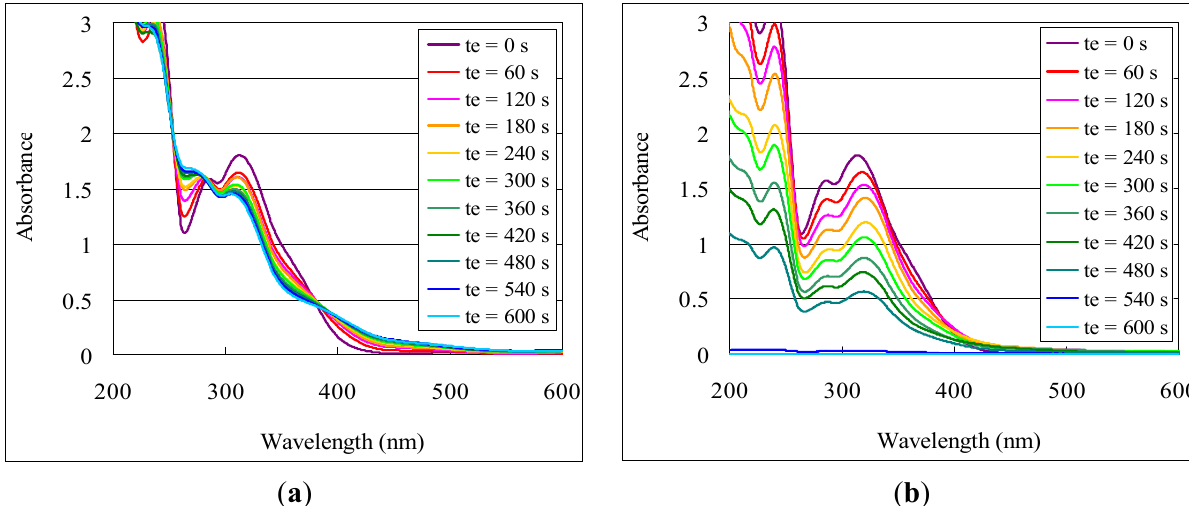
Figure 3. Photo-induced solubility of 2 -Ho films, monitored by UV-Vis spectra of 2 -Ho films ( a ) exposed to UVB irradiation for time t irradiated films.